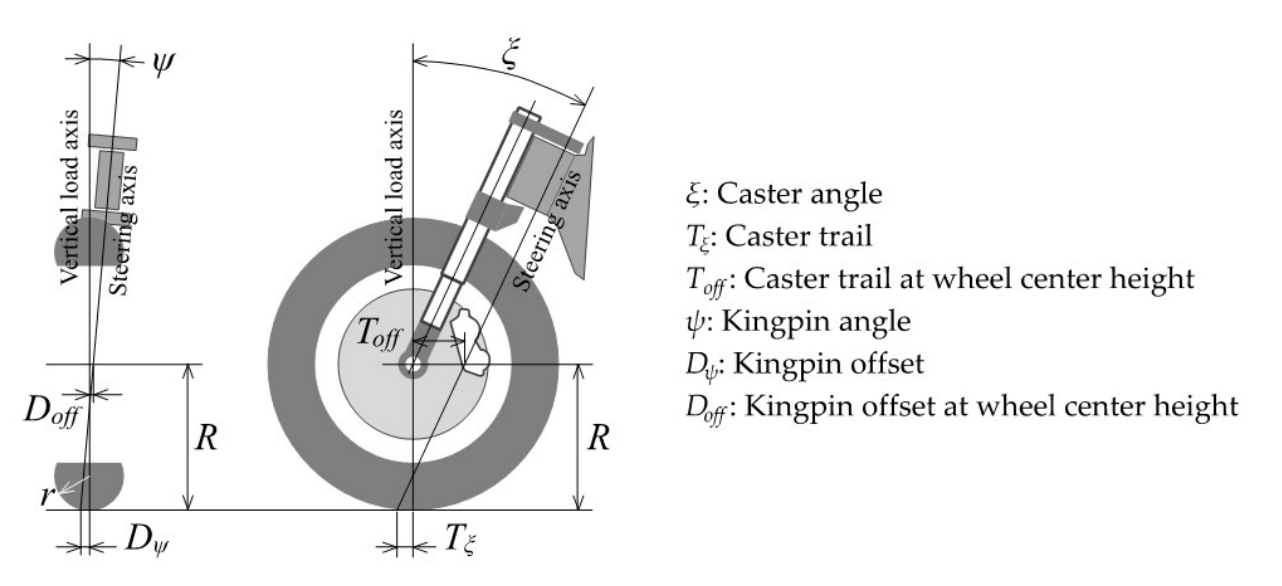
Figure 4. Steering axis and four independent